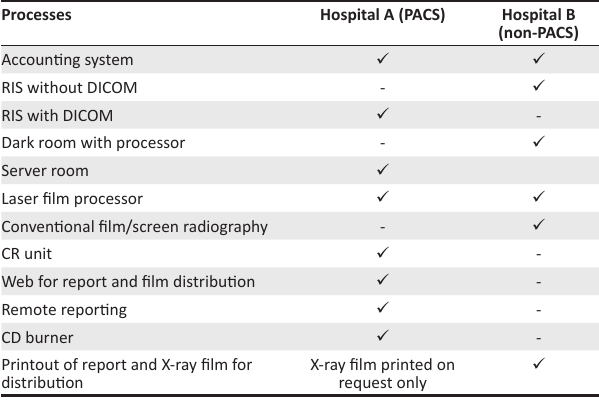
TABLE 1: A comparison of systems and processes used to produce radiographs in a hospital using PACS (Hospital A) and one using conventional radiography (Hospital